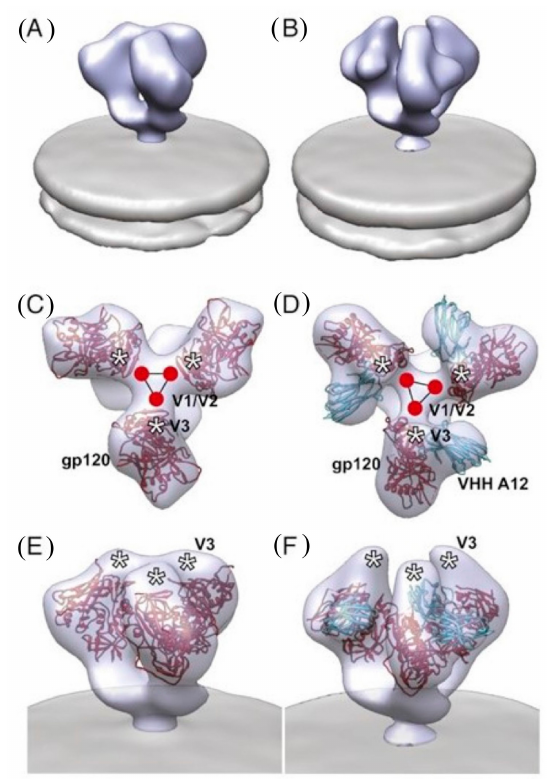
Figure 5. Cryo-electron microscopic tomograms of gp160 trimers on HIV particles with and without bound complementarity-determining (CD)4bs nanobody A12. ( A , B ): Perspective views of density maps for Envelope Trimer (Env) in the unbound ( A ) and A12-bound ( B ) states. ( C , D ): Top view and ( E , F ): Perspective view of the density map and molecular architecture of unbound and A12-bound trimeric Env, respectively. Cocrystal coordinate models show gp120 (red) and variable domains of heavy-chain only antibodies (VHH) A12 (cyan). The estimated locations of the V1 / V2 and V3 loops are highlighted by the red circles and white asterisks, respectively. The partially open conformation of the V3 loop region in the A12-bound form is evident in ( F ). Reproduced by permission from Meyerson et al.